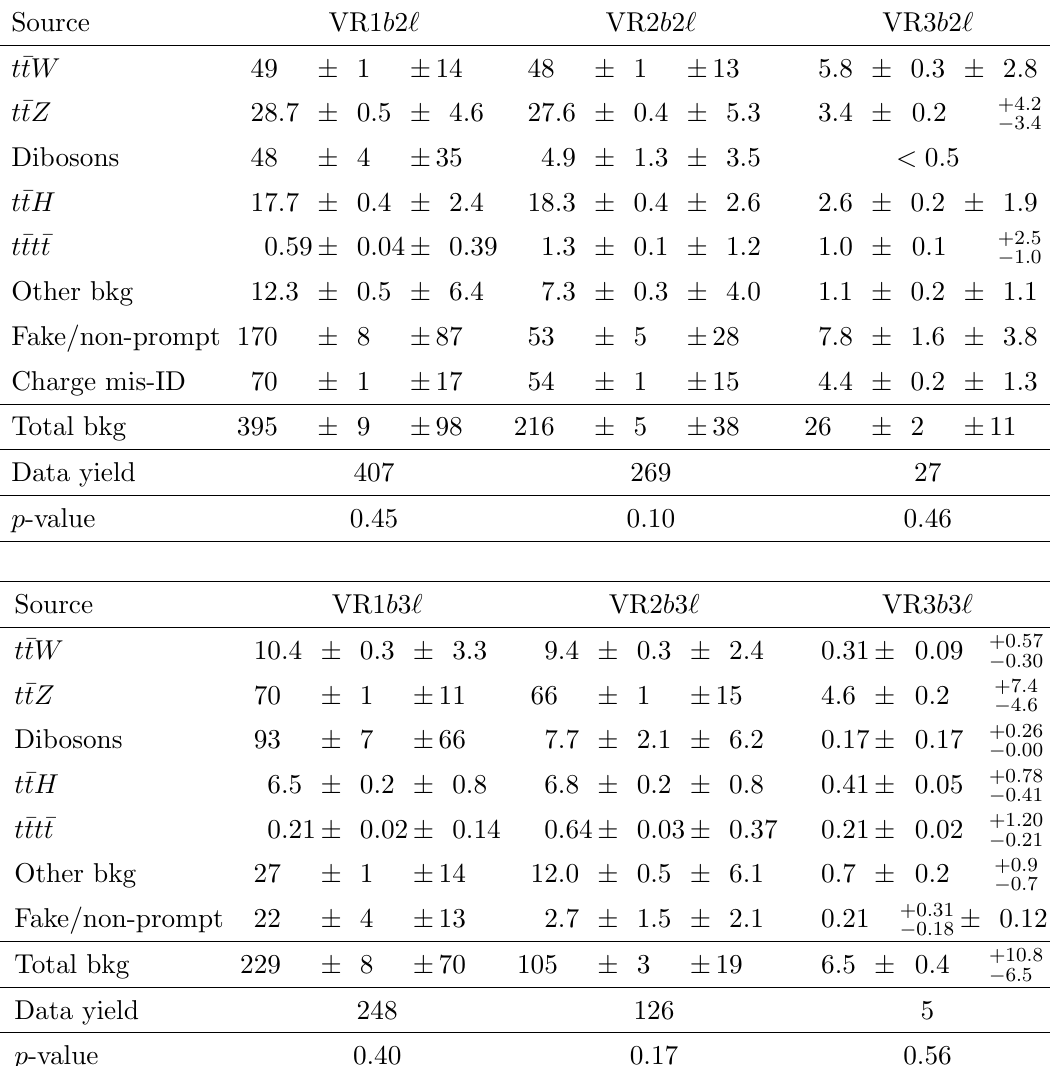
Table 6 . Expected background and observed event yields in the validation regions used in the VLQ and four-top-quark searches. The ‘Other bkg’ category includes contributions from all rare SM processes listed in section 6. The (cid:12)rst uncertainty is statistical and the second is systematic. The p -values are the probabilities for the expected background to (cid:13)uctuate to equal or exceed the observed yield in each